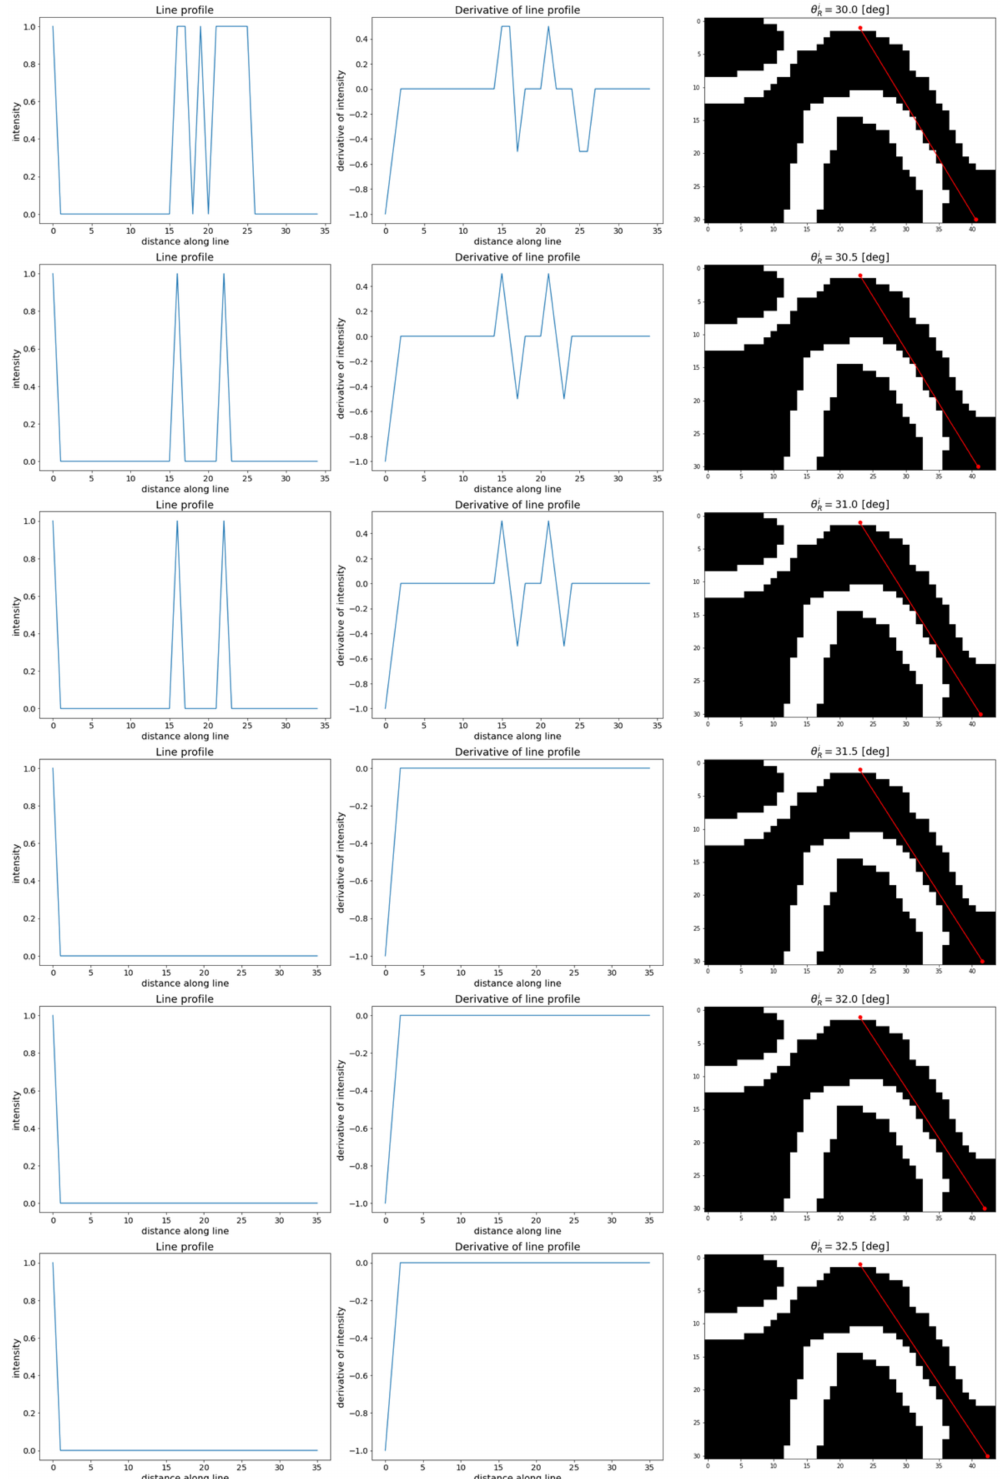
Figure 12. Iterative procedure results for the determination of the TMJ head tangent